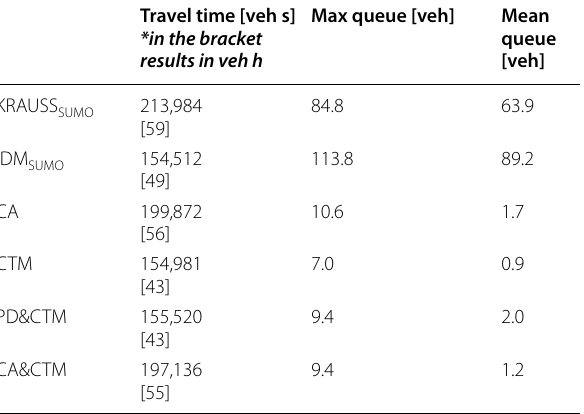
Table 3 Numerical results of the artery application